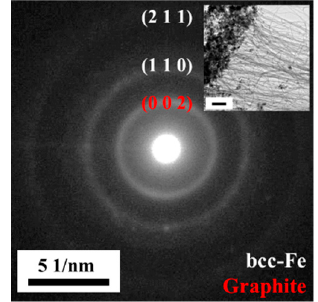
Figure 1 . An electron diffraction pattern of the Fe nanoparticles after Plasma-enhanced chemical vapor deposition (PECVD). Inset shows the TEM image of nanoparticles attached to the carbon nanotubes (CNTs). Scale bar in the inset shows 100 nm.